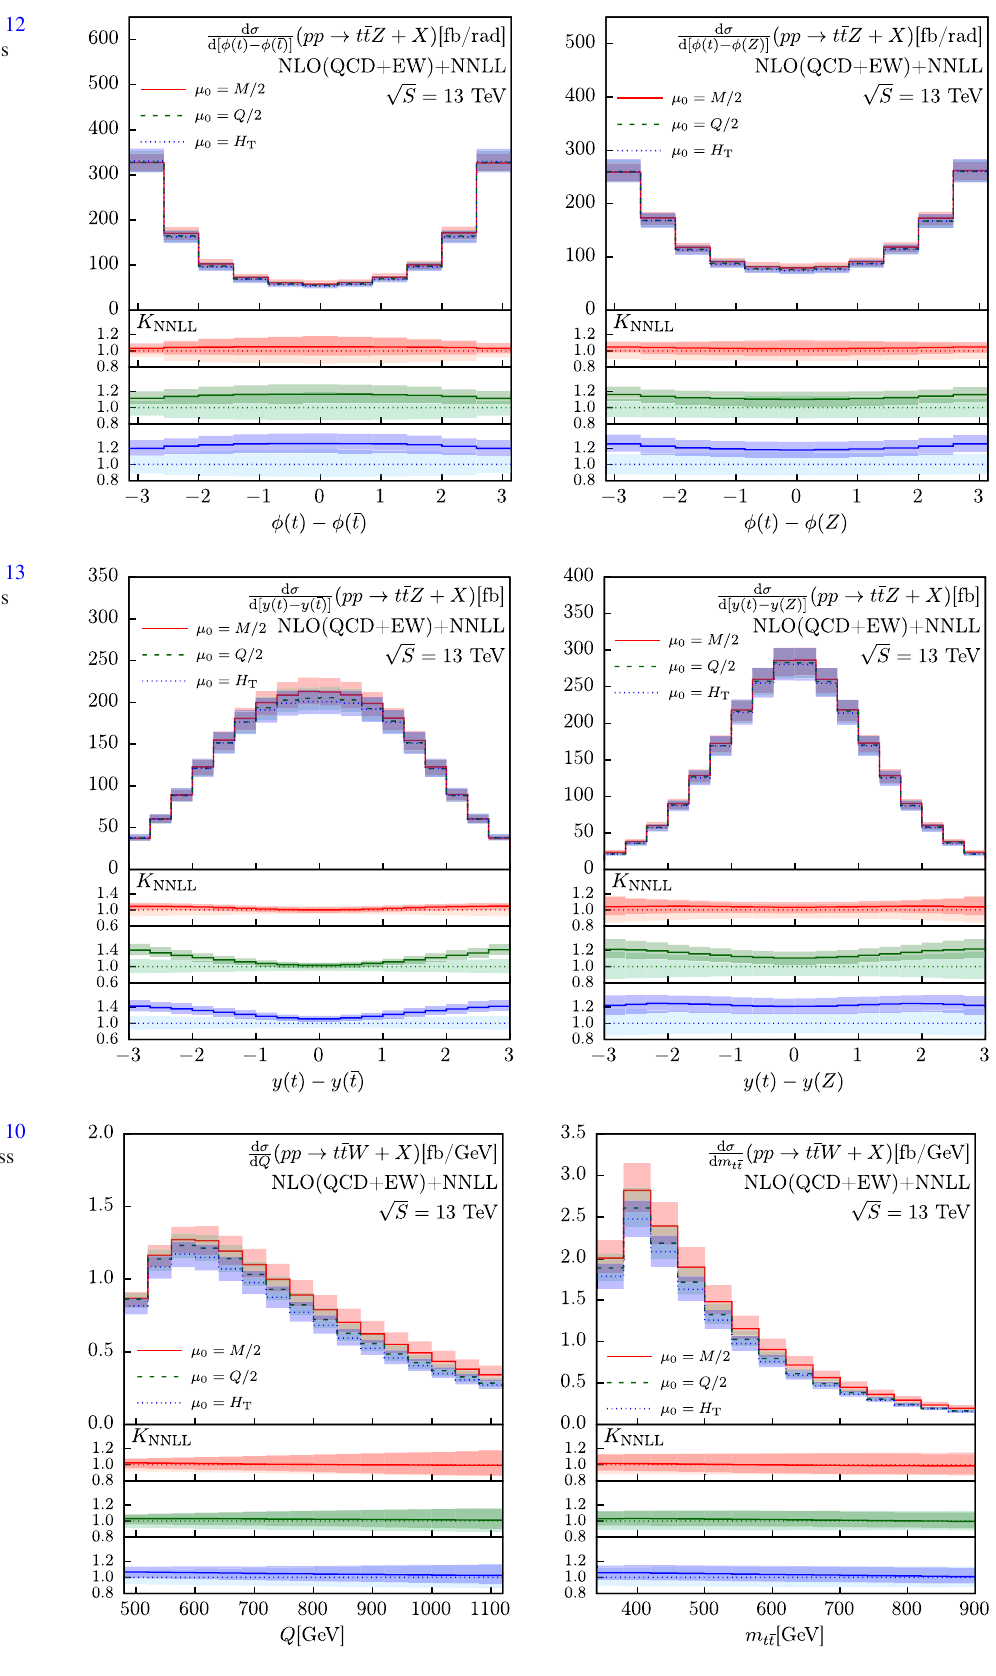
Fig. 18 The same as in Fig. 10 but for the pp → t ¯ tW